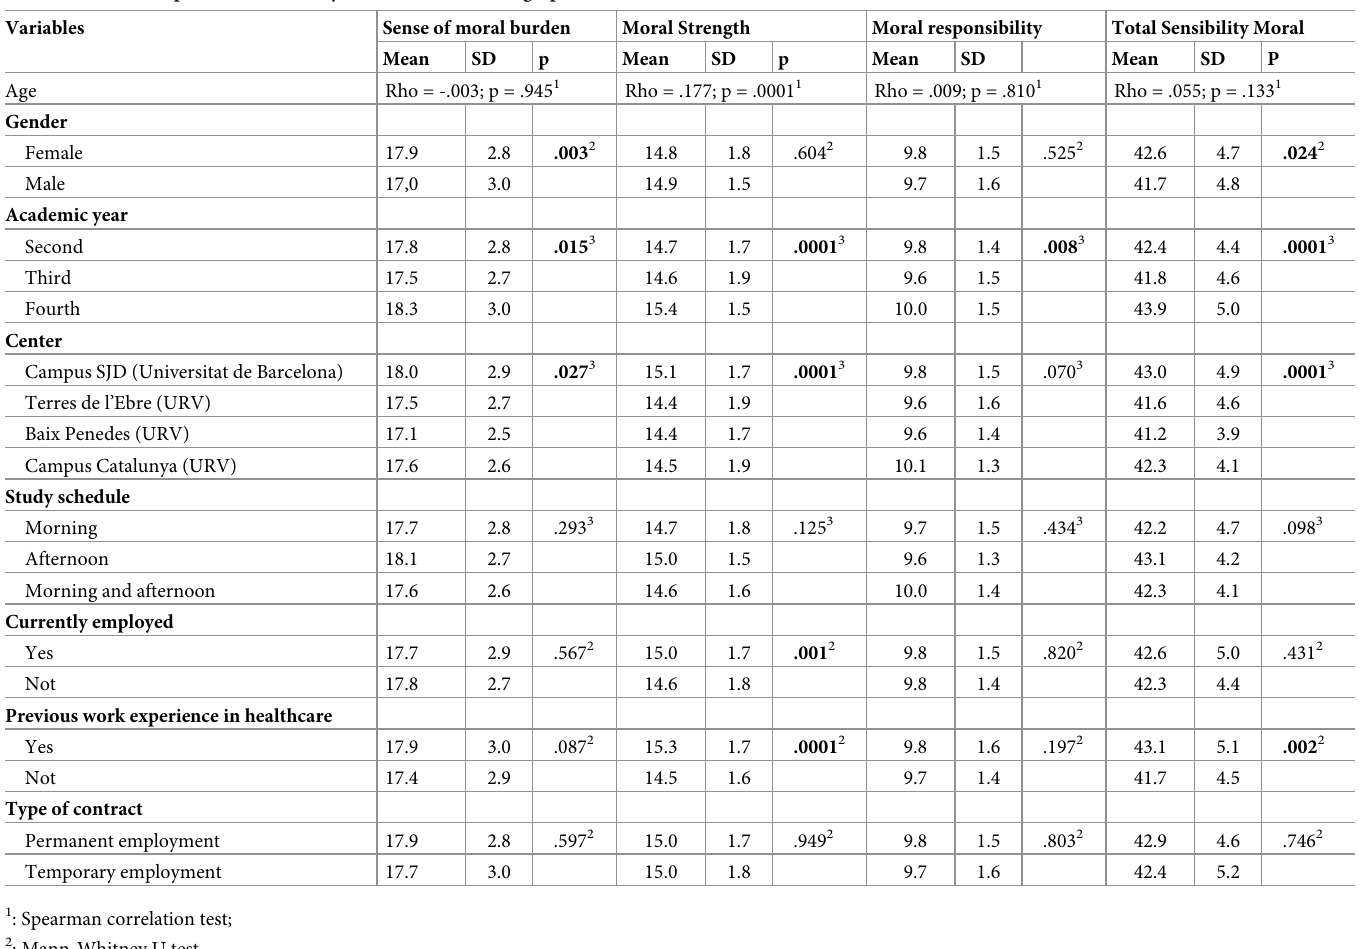
Table 6. Levels of exposure to sensitivity moral and sociodemographic characteristics. Sense of moral burden Moral Strength Moral responsibility Total Sensibility